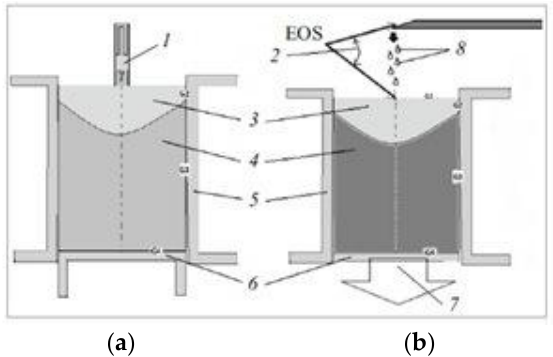
Figure 1. Schematic diagram of the EBMR process: ( a ) a scheme of the method of disk melting and ( b ) a scheme of the method of drip melting with a horizontal feeding of the source material: (1) electron beam; (2) scanning electron beam (formed in one or several electron optical systems EOS); (3) pool of liquid metal; (4) solidifying ingot; (5) water-cooled side walls of the copper crucible; (6) water-cooled mobile bottom (puller); (7) direction of elongation of ingot; and (8) drops of molten metal [4,39].